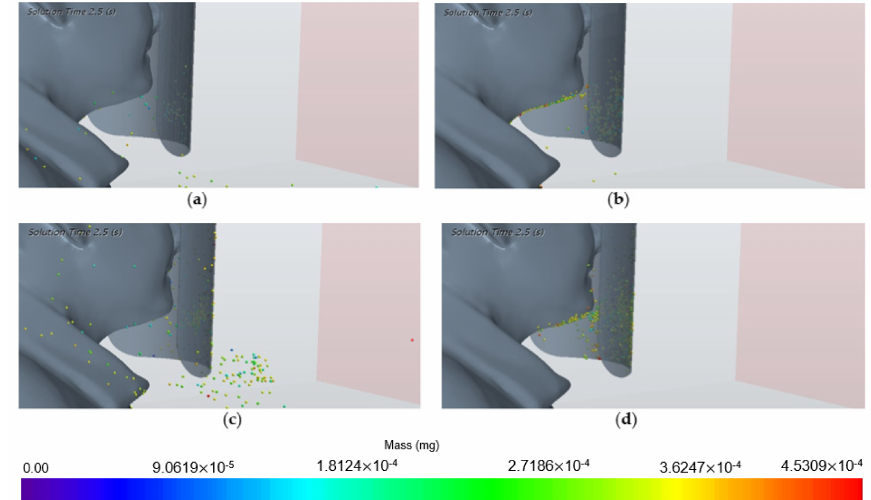
Figure 11. Mass of the droplets entering the face shield at 40% RH and T e = 25 ◦ C. ( a ) Wind speed of 7 km/h and the mouths at the same height; ( b ) Wind speed of 14 km/h and the mouths at the same height; ( c ) Wind speed of 7 km/h and the mouths with a height difference of 20 cm; ( d ) Wind speed of 14 km/h and the mouths with a height difference of 20